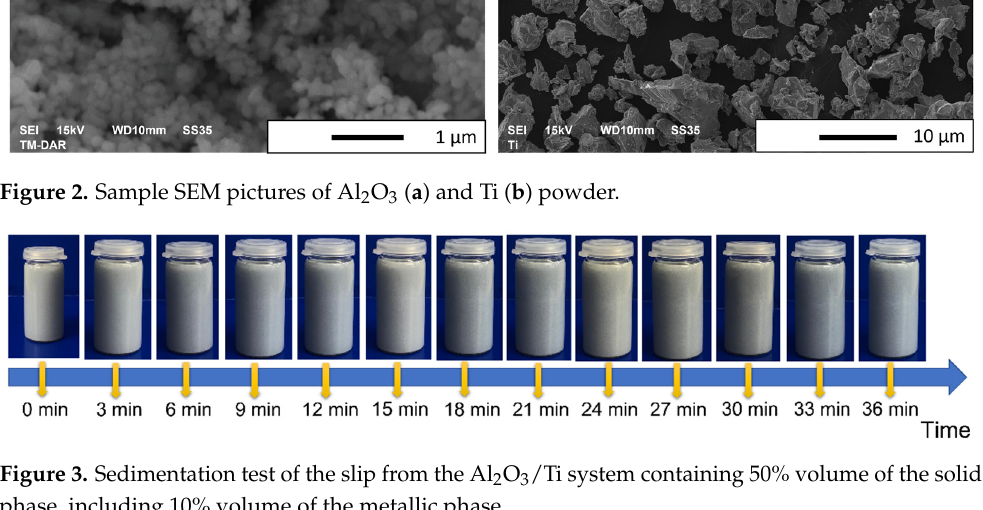
Figure 3. Sedimentation test of the slip from the Al 2 O 3 /Ti system containing 50% volume of the solid phase, including 10% volume of the metallic phase.